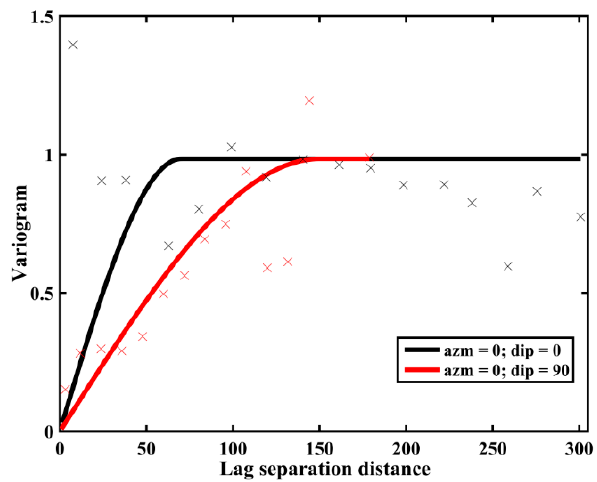
Figure 8. Modogram and rodogram for detection of anisotropy for RQD variable; red line shows the vertical anisotropy.